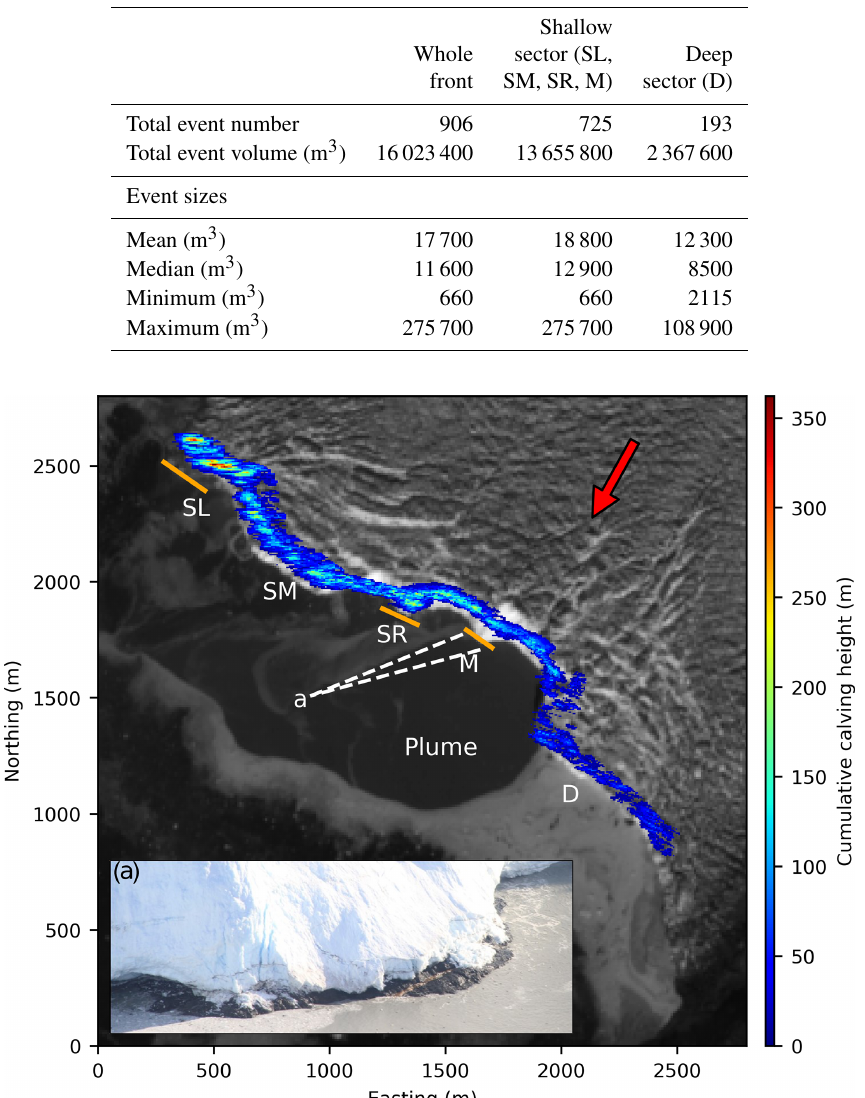
Table 1. Detected calving events within each sector during the observation period of 6.12d.